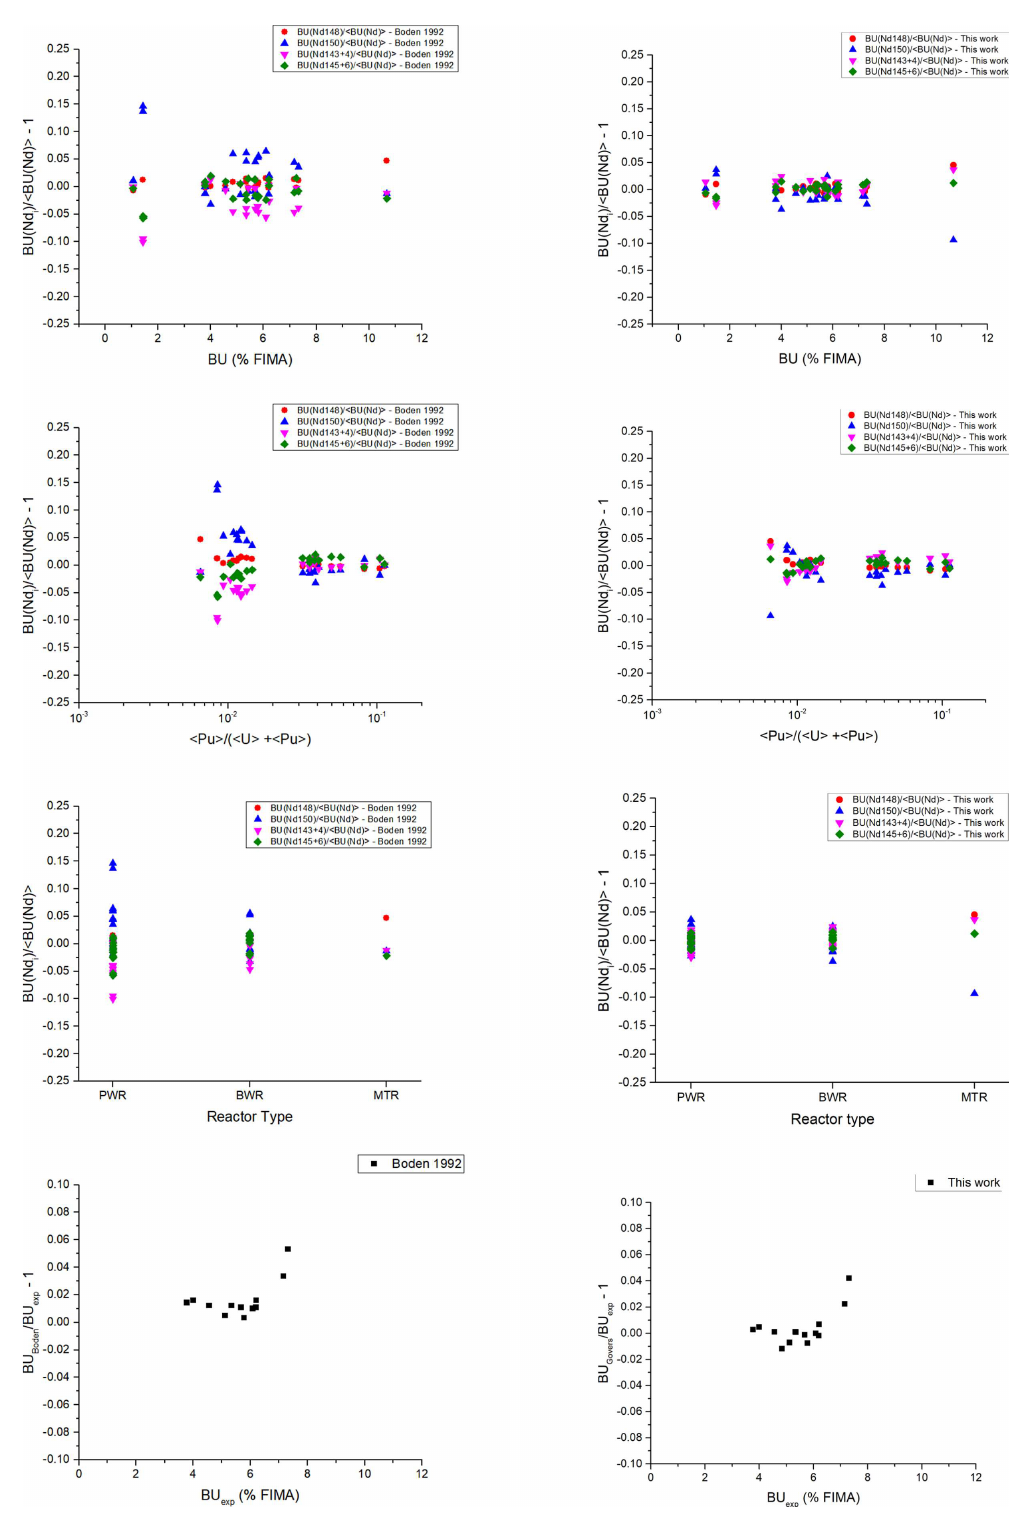
Fig. 6. Burnup derived from different Nd isotopes ( 148 Nd, 150 Nd, 143 Nd+ 144 Nd, and 145 Nd+ 146 Nd) according to the approach proposed by Boden et al. [17] (left column) and in this work (right column). The same set of data is expressed as a function of burnup (top row), Pu content (second row) and reactor type (third row). The ratio of average burnup to reported burnup is presented in the bottom row. Here, only data for which the burnup was assessed by cross check analyses are